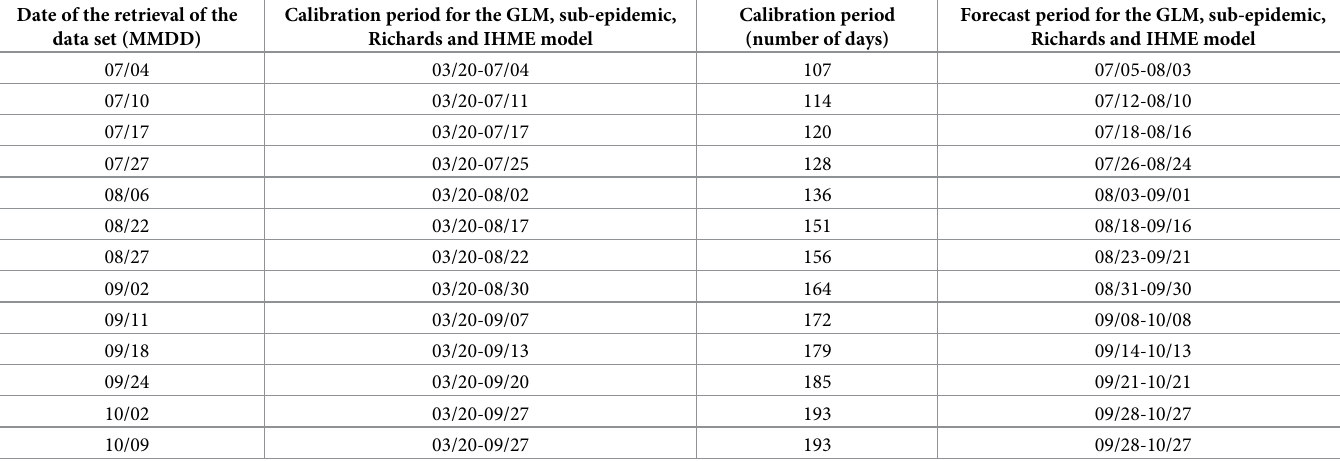
Table 1. Characteristics of the data sets used for the sequential calibration and forecasting of the COVID-19 pandemic in Mexico and Mexico City (2020). Date of the retrieval of the Calibration period for the GLM, sub-epidemic, data set (MMDD) Richards and IHME model